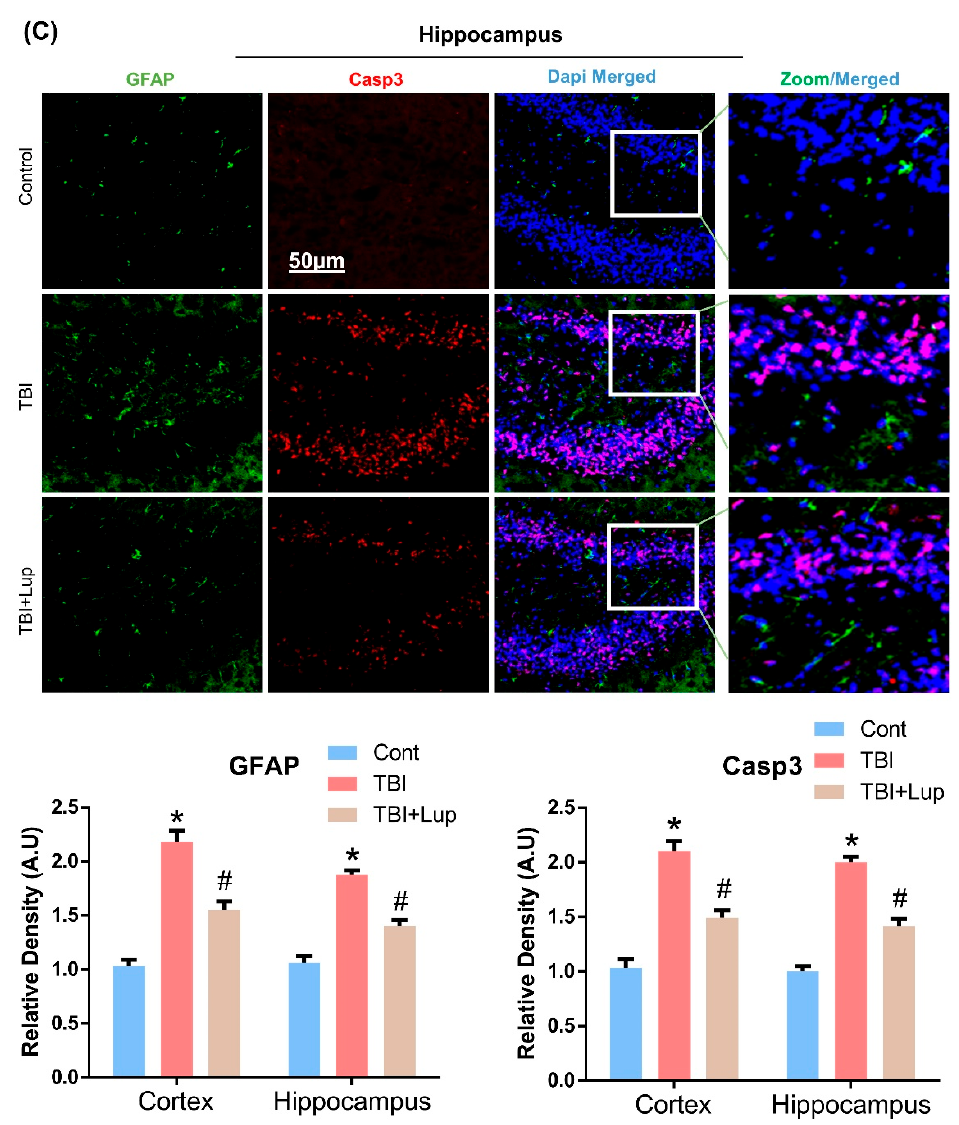
Figure 4. Lupeol reversed the TBI-induced apoptotic cell death in the mouse brain. ( A ) Western blot analysis of proapoptotic protein caspase-3, Bax, cytochrome-C, and antiapoptotic protein expression (Bcl2) in the cortex and hippocampus of mice; ( B ) immunofluorescence images of the colocalized reactivity of GFAP (FITC—green), Casp3 (red), stained with DAPI (blue) in the cortex region; ( C ) immunofluorescence images of the colocalized reactivity of GFAP (FITC—green), Casp3 (red), stained with DAPI (blue) in the hippocampus region. The zoom represents high magnification. The cropped bands were quantified using Image software, and the differences are represented in the histogram. Asterisk (*) sign indicates significant difference from the normal saline-treated group; hash (#) sign indicates significant difference from the TBI-treated group. Bar = 50µm. The density values are expressed in arbitrary units as the mean ± SEM of the indicated proteins ( n = 6 animals per group). Significance = p ≤ 0.05.